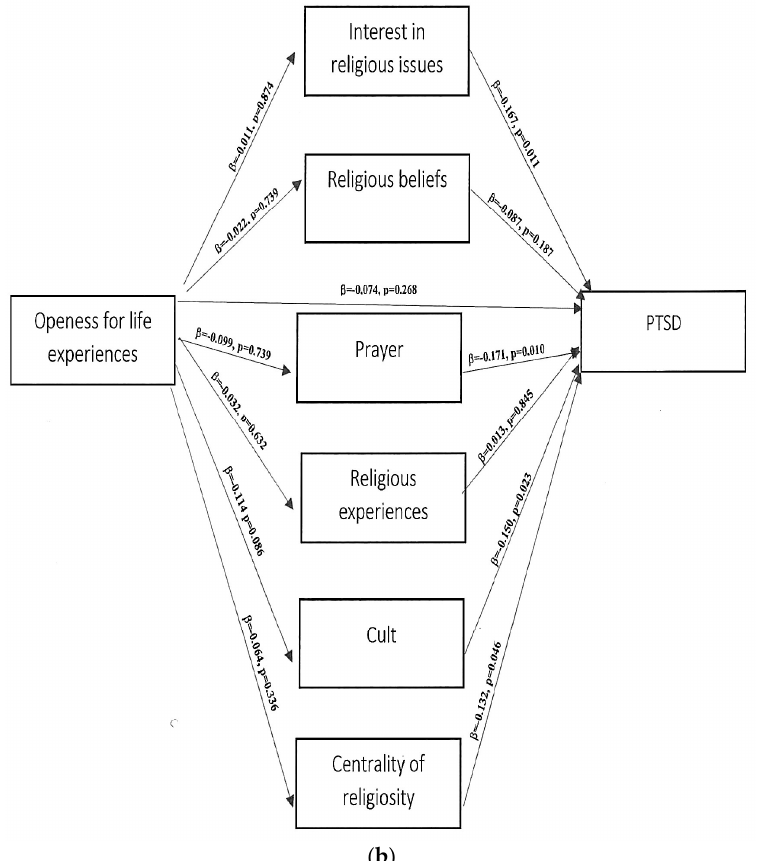
Figure 3. ( a , b ). Path analytical model of the inter-relationship between the study variables ego- resiliency, religiosity, and PTSD.